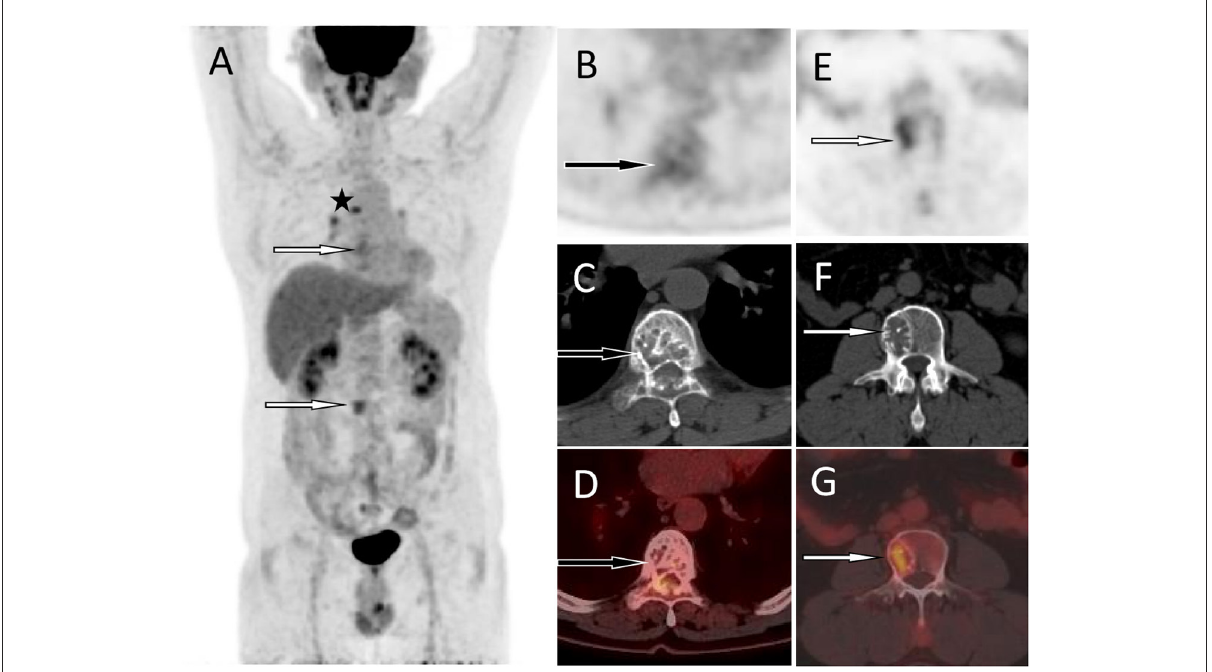
FIGURE2 18 F-FDG PET/CT was then performed to assess the nature of the lesion and the patient’s systemic condition. The MIP (A) showed mild radiation uptake in the T7 area (the black arrow) and increased FDG uptake in the L3 lesion area (the white arrow). In addition, there is radioactive uptake of lymph nodes in the mediastinum (the asterisk arrow), which are pathologically confirmed as inflammatory. The axial figures at the T7 level [ (B) PET; (C) CT; (D) PET/CT fusion] showed the destruction of bone density in the vertebral body and adnexa, presenting a “fence-like” change, with a slight increase in FDG uptake and an SUVmax of 3.0 (black arrows). An axial map at the L3 level [ (E) PET; (F) CT; (G) PET/CT fusion] showed destruction of bone density in the right portion of the vertebral body with increased FDG uptake and SUVmax of 4.5 (white arrows). Based on these imaging findings, the patient was considered to have hemangiomas. Based on pathological and immunohistochemical findings, the patient was confirmed to have plasma cell myeloma.